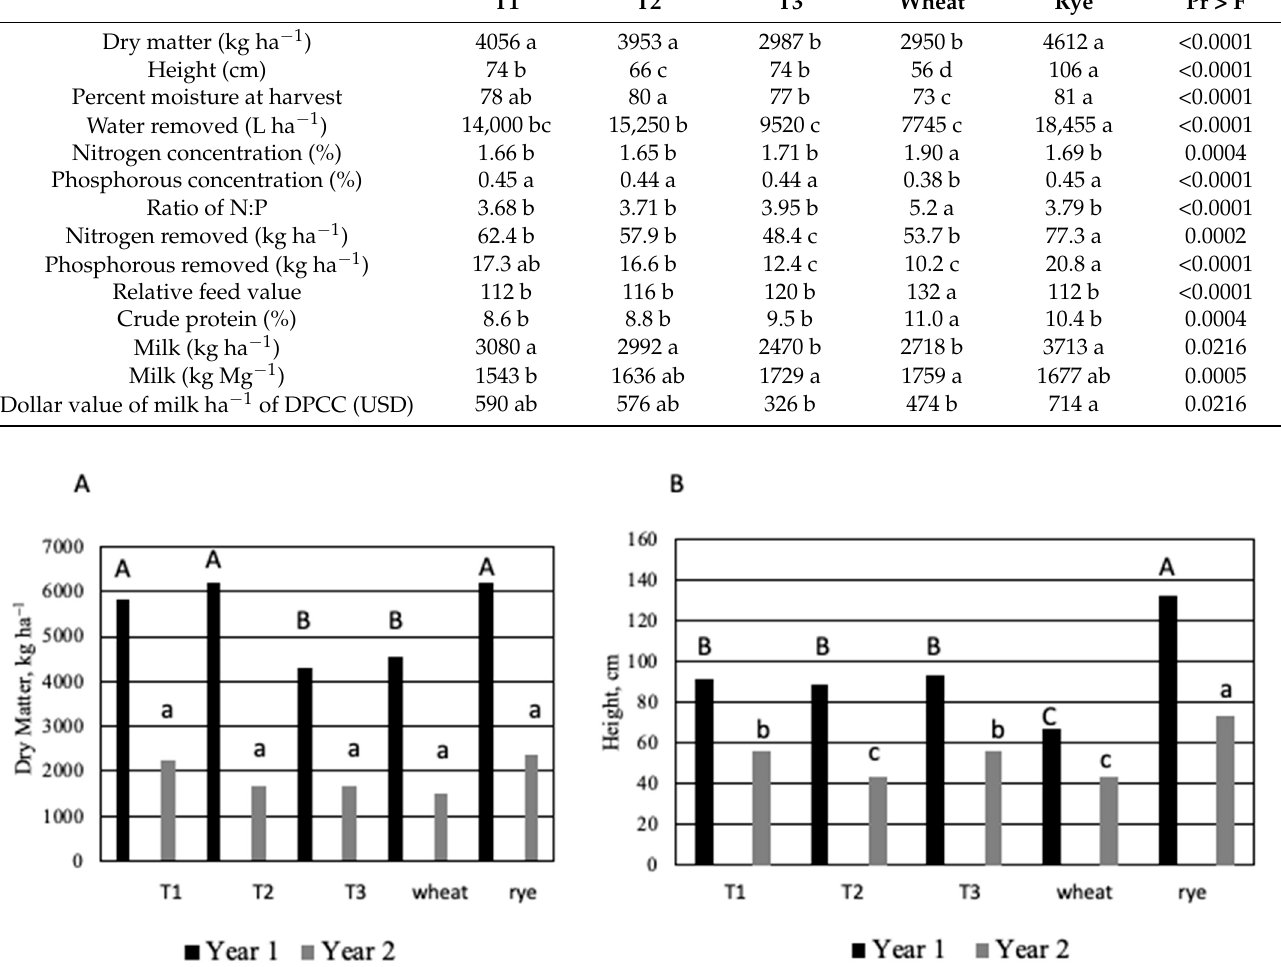
Figure 2. ( A ) Dry matter produced by DPCCs each year. ( B ) Heights of DPCCs within each exper- imental year. Means separated by Tukey’s HSD range test. Within the same row, values followed by different letters are statistically different. Uppercase letters are associated with values in year 1; lowercase letters are associated with values in year